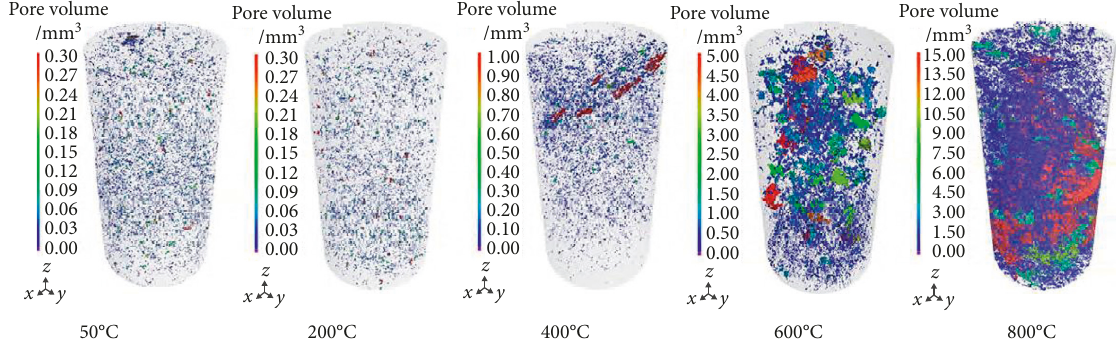
Figure 8: Rendering model of microfracture after thermal treatment at different temperatures.